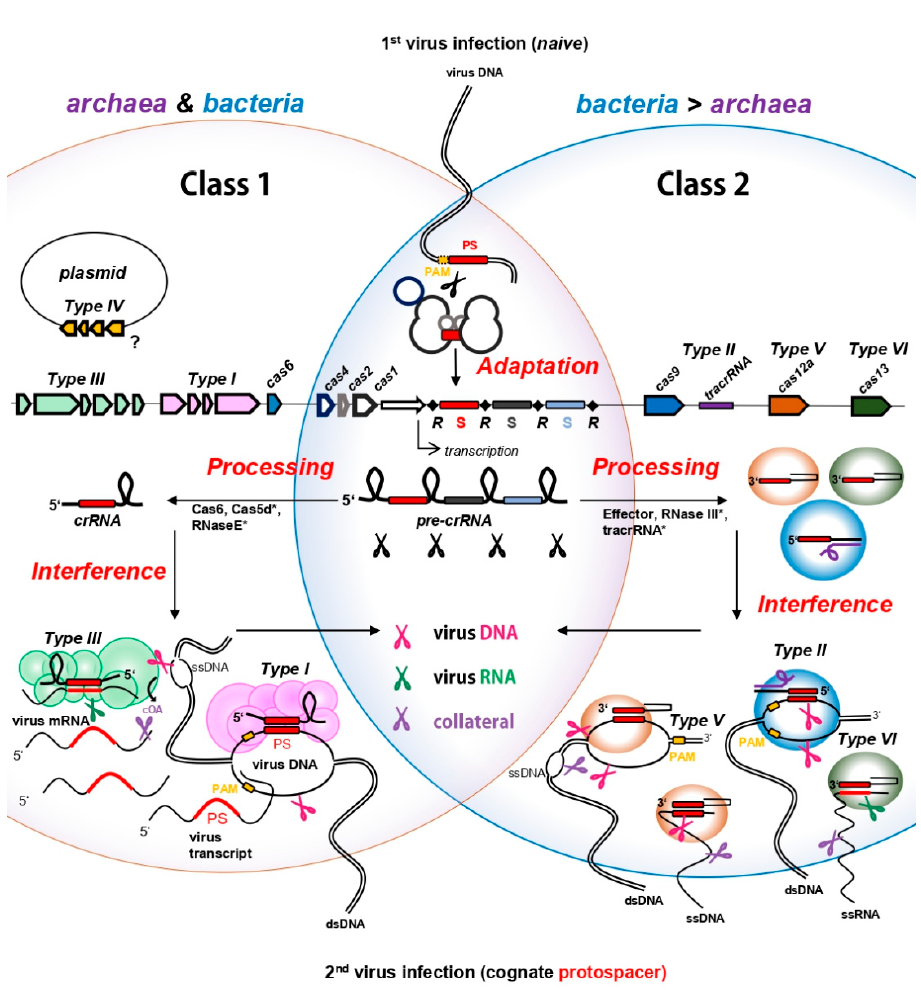
Figure 1. CRISPR types in prokaryotes and their mechanisms of action. Class 1 systems (including types I, III, and IV) are prevalent in both archaea and bacteria, whereas Class 2 systems (including types II, V and VI) are found almost exclusively in bacteria. Mechanisms and genes in the overlapping region are shared by the two classes. The different CRISPR steps are indicated in red and explained in the main text. Both classes contain effector complexes that can perform all three types of interference: virus DNA interference (indicated by pink scissors), virus RNA interference (indicated by green scissors) and collateral damage (i.e., promiscuous cleavage of host and virus DNA/RNA, indicated by purple scissors). “S” refers to “spacer”, “R” refers to “repeat”. * Asterisks refer to enzymes that are not involved in processing of all classes: Cas5d replaces Cas6 function in type I-C [25]; RNaseE is involved in processing in a type III-B system [26]; RNase III processes pre-crRNA in type II; tracrRNA is needed in type II and certain subtypes of type V (see text). Type I-D targets ssDNA and dsDNA (not shown) [27]; In type II systems, Csn2 is also involved in spacer acquisition (not shown); spacer acquisition from RNA via RTs is not shown [28]; ssRNA targeting of the type V-G subtype is not shown [29] (see text).